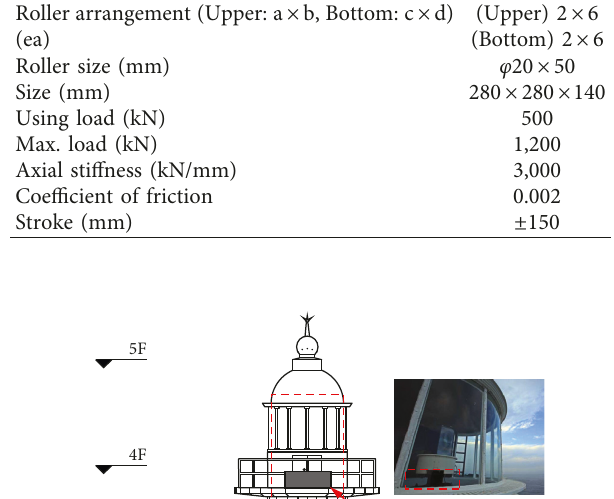
Table 6: RB device details.